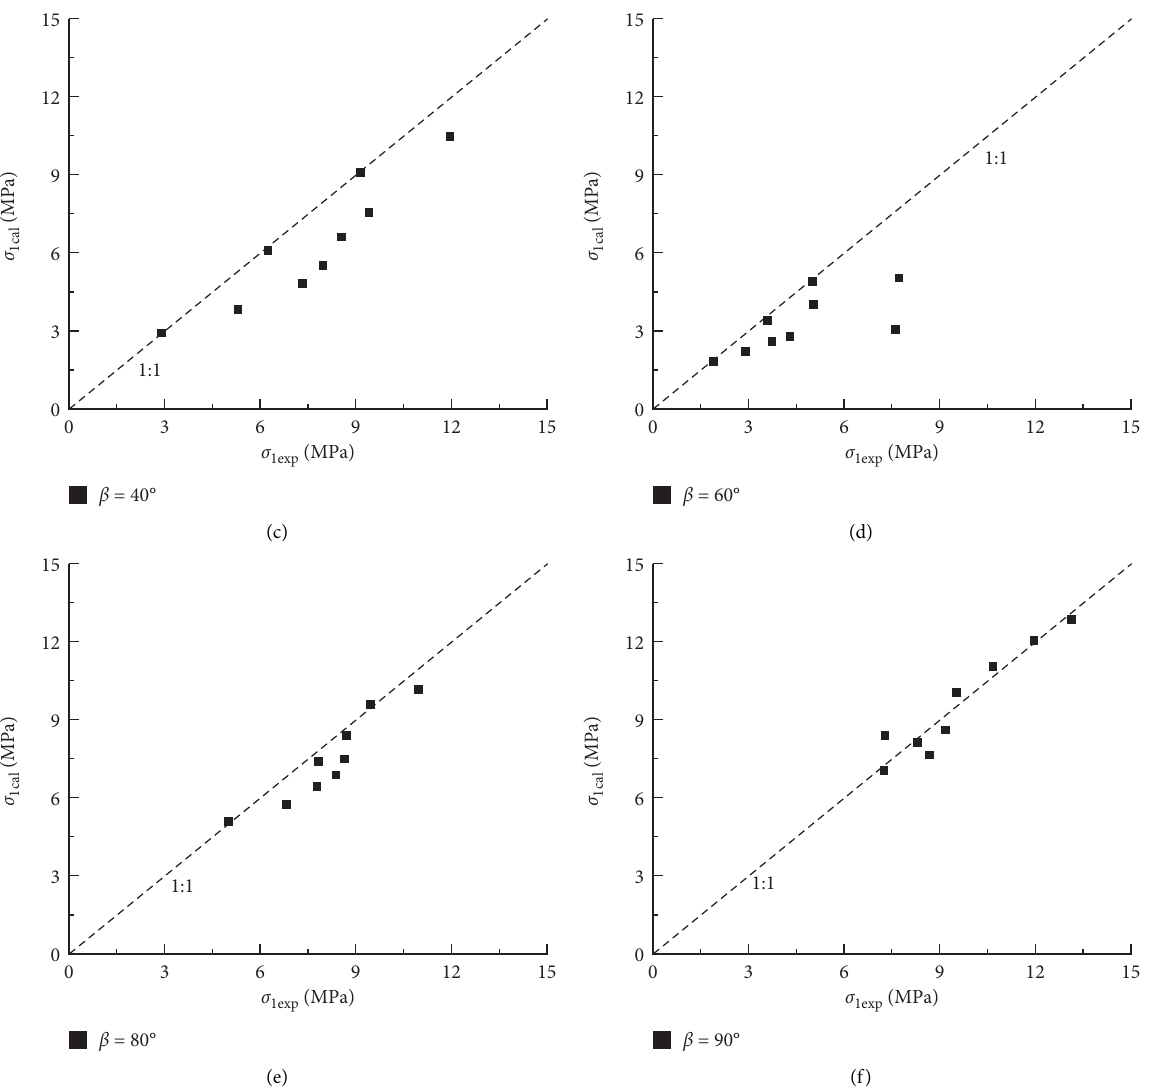
Figure 6: The comparison results of the calculated and experimental strength of jointed blocky mass for different joint inclination angles: (a–f) β � 0 ° , 20 ° , 40 ° , 60 ° , 80 ° , and 90 °